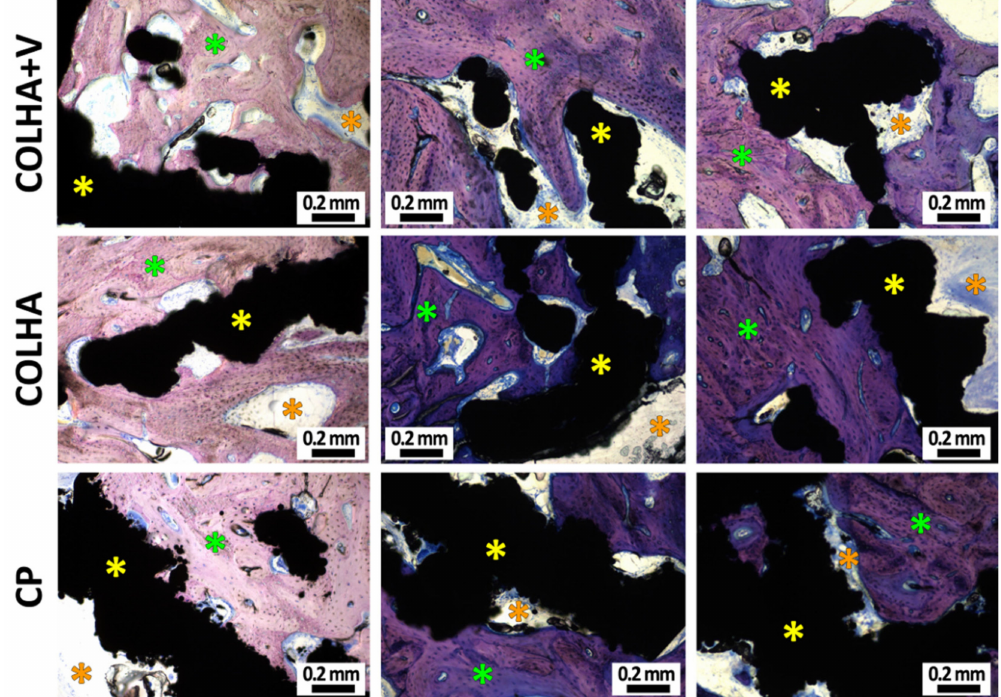
Figure 8. Representative histological images (Giemsa’s azur eosin methylene blue staining) of the printed titanium implants with collagen/hydroxyapatite layers without (COLHA) and loaded with vancomycin (COLHA+V) and the printed titanium control samples (CP). The green stars represent bone tissue outside of the implants, the orange stars represent connective tissue, and the yellow stars the